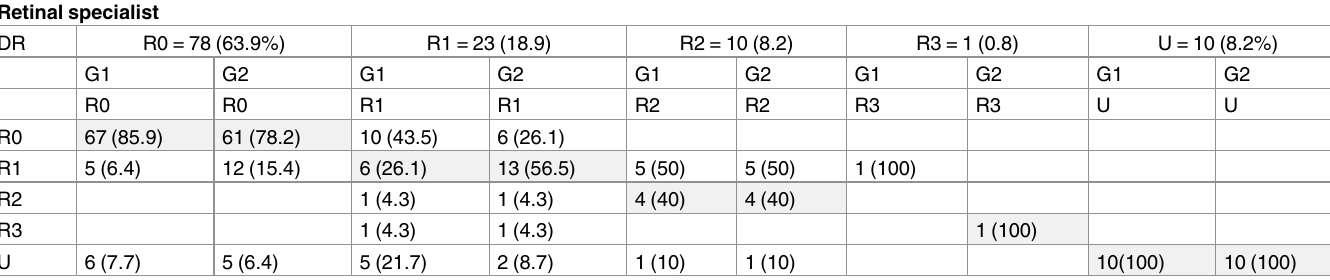
Table 4. Comparison of diabetic retinopathy graded by the retinal specialist and the local graders. Retinal specialist DR